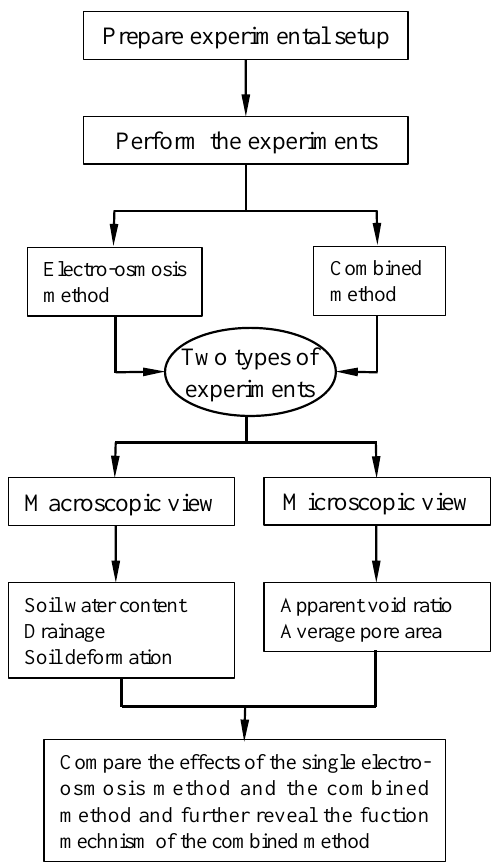
Figure 2. Flowchart of the research methodology.